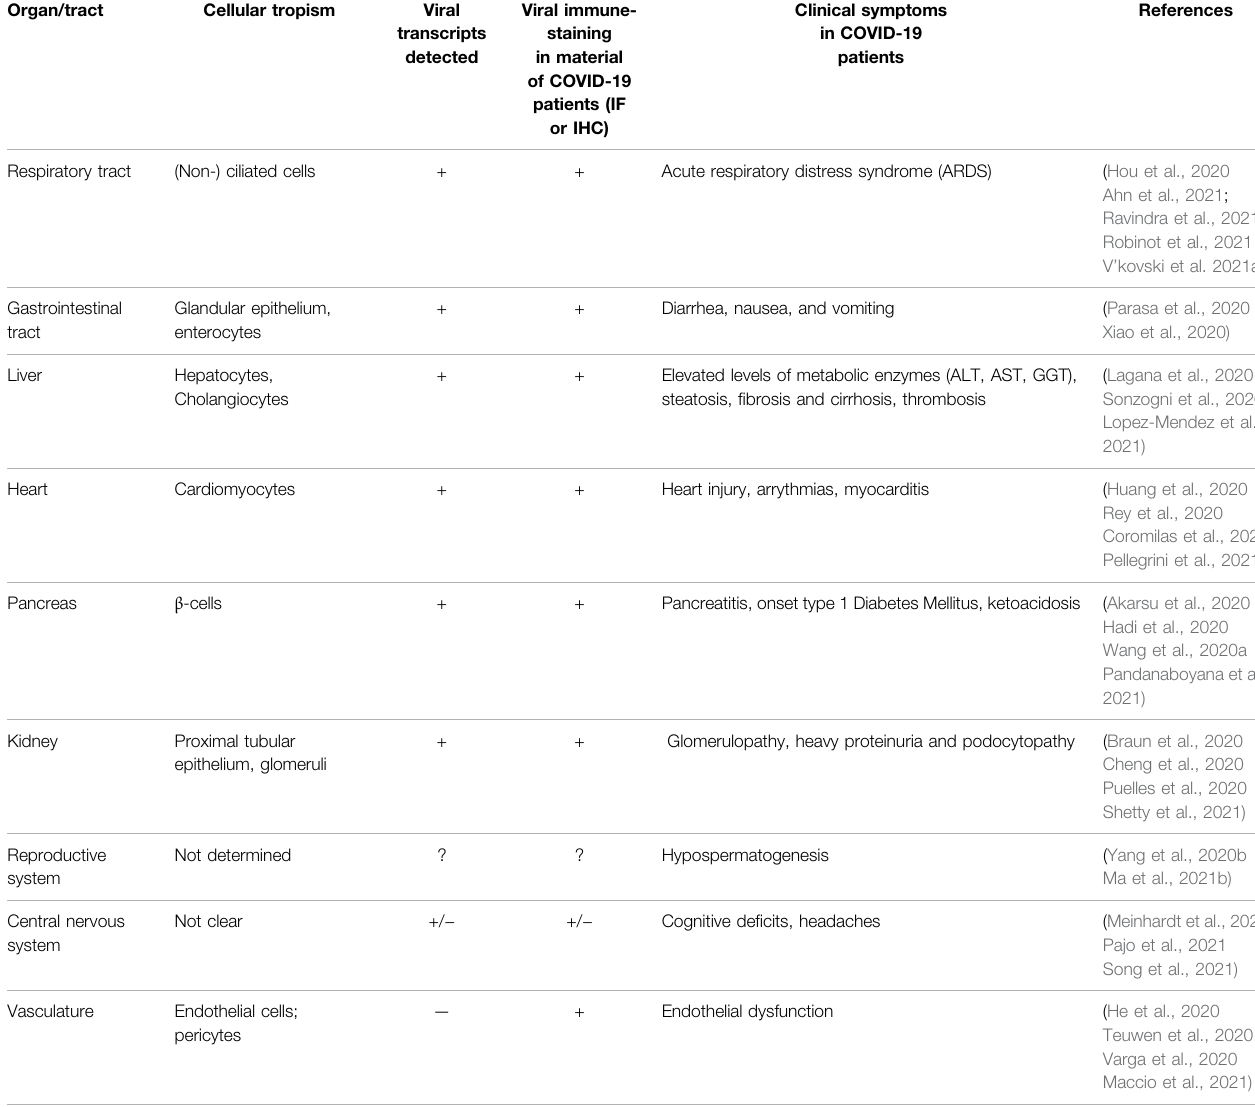
TABLE 1 | Overview of various organs susceptible to viral infection with SARS-CoV-2 and their clinical symptoms in COVID-19 patients.